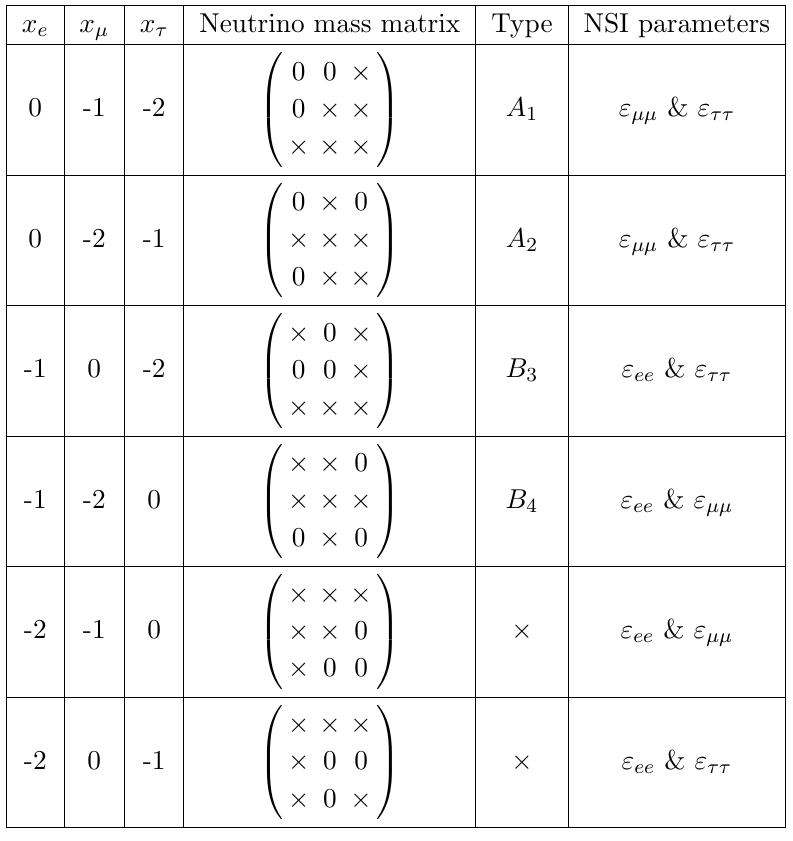
Table 3 . Neutrino mass matrix textures depending on the choices of the charges x (cid:11) . Notice that only four of these two zero textures are allowed by the latest neutrino oscillation data